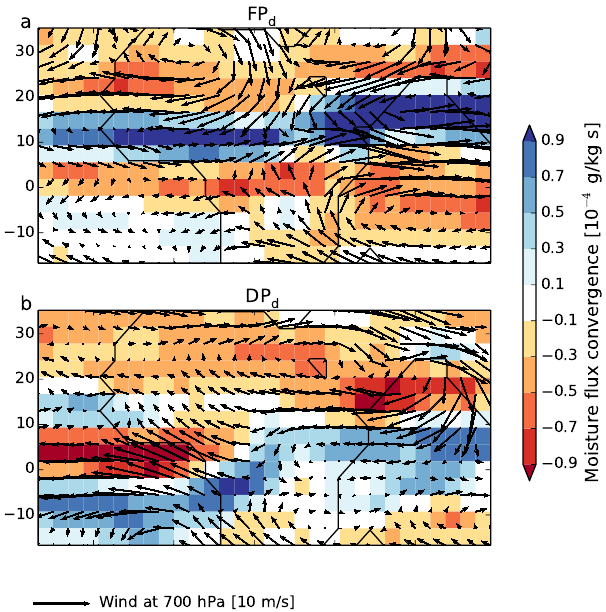
Figure 12. Horizontal wind at 700hPa averaged over July, August, and September in the last 30 years of the FP d simulation and DE d simulation. Colours show the moisture flux